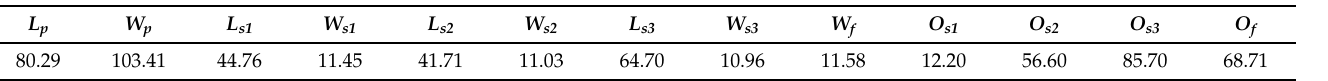
Table 3. Optimal solution (decision variables of the optimization process) of the proposed modified E-shaped patch antenna as illustrated in Figure 2a (values are expressed in